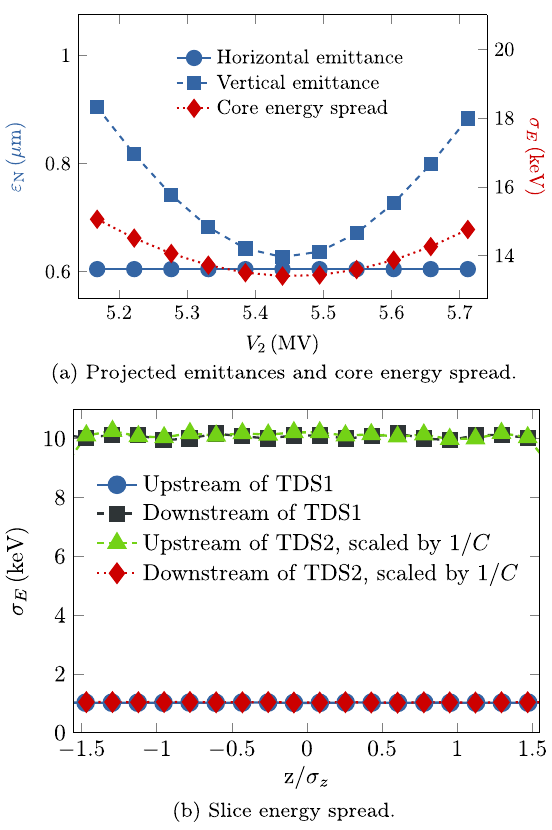
FIG. 4. Simulations without CSR effects on the impact of the reversible heater system on projected emittances, core energy spread, and slice energy spread: (a) Projected emittances (normalized) and core energy spread, and (b) slice energy spread for V 2 at minimum emittance [see Fig. 4(a)]. The longitudinal coordinate is normalized to the bunch length.